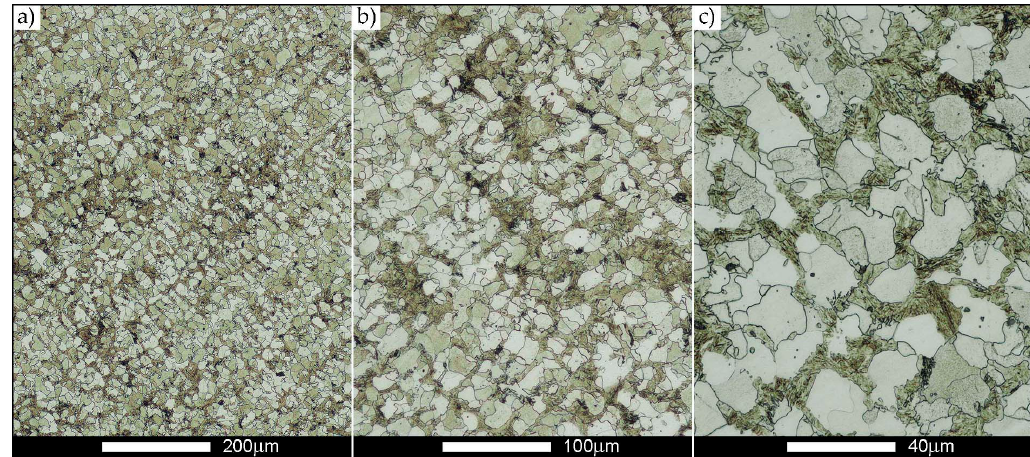
Figure 36. Welded joint microstructure of Hardox 450 in the delivery state (directly after welding) with revealed grain boundaries of prior austenite—WM2 zone shown in Figure 2. ( a ) 100 × ; ( b ) 200 × ; ( c ) 500 ×